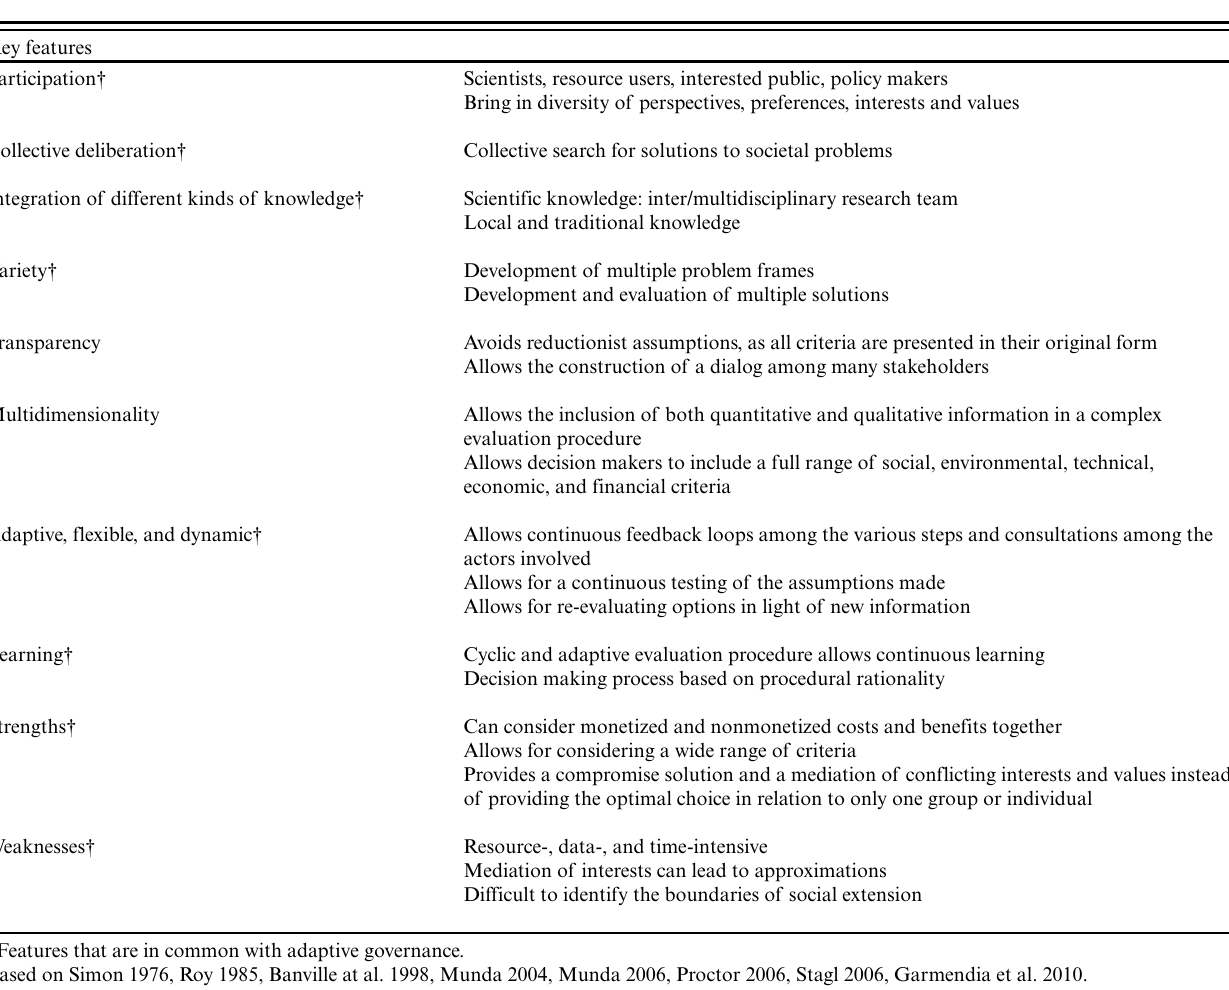
Table 3 . Key features of participatory multicriteria